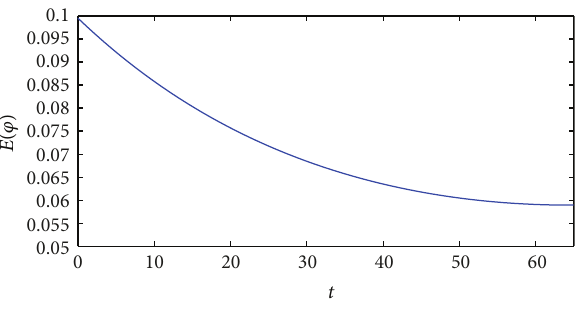
Figure 1: The expectation of 𝜙